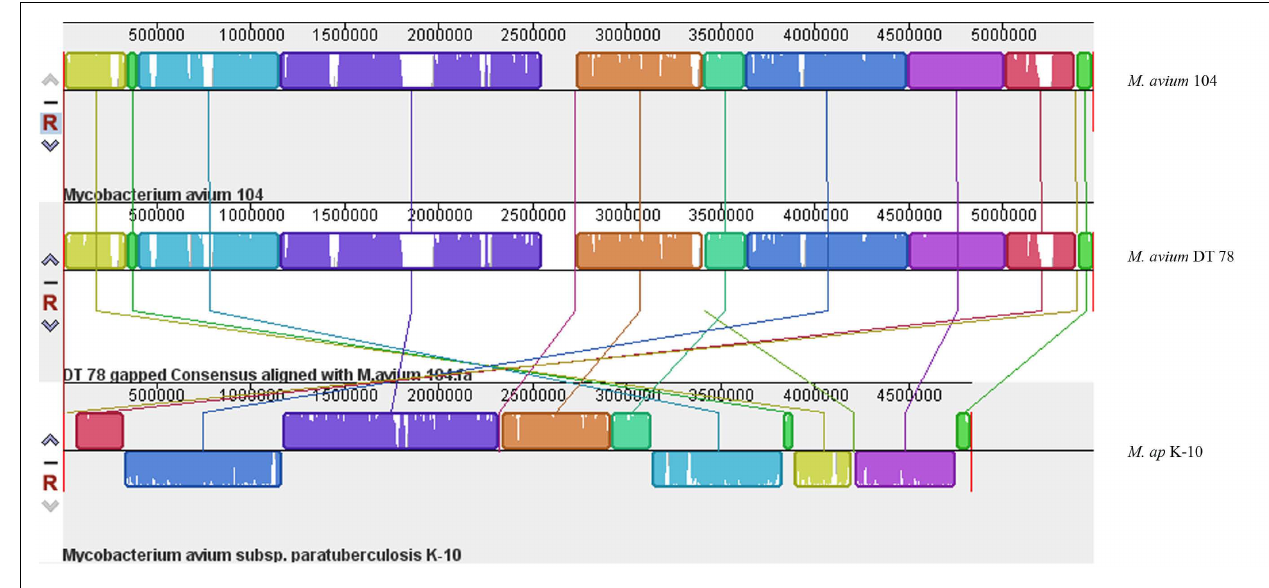
FIGURE 1 |A whole-genome alignment of M. avium DT 78, M. avium 104 and M. ap DT 78. MAUVE algorithm (Darling et al., 2010) was used for the alignment of the three genomes where white areas indicate low coverage gaps in the sequence of M. avium DT 78 genome, and about